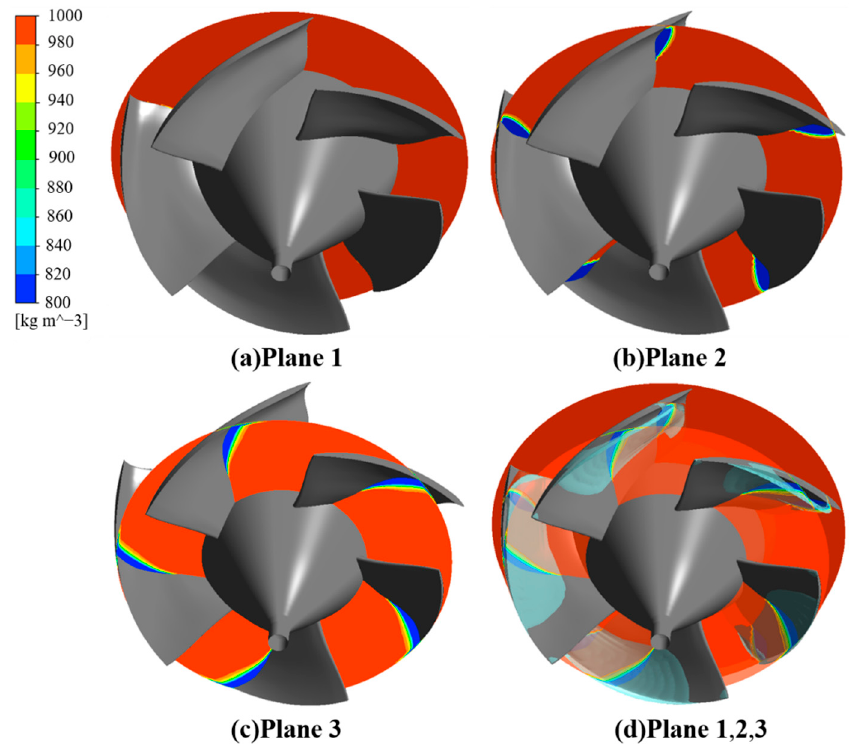
Figure 18. Contours of the density on different planes under the Breakdown Cavitation Condition.